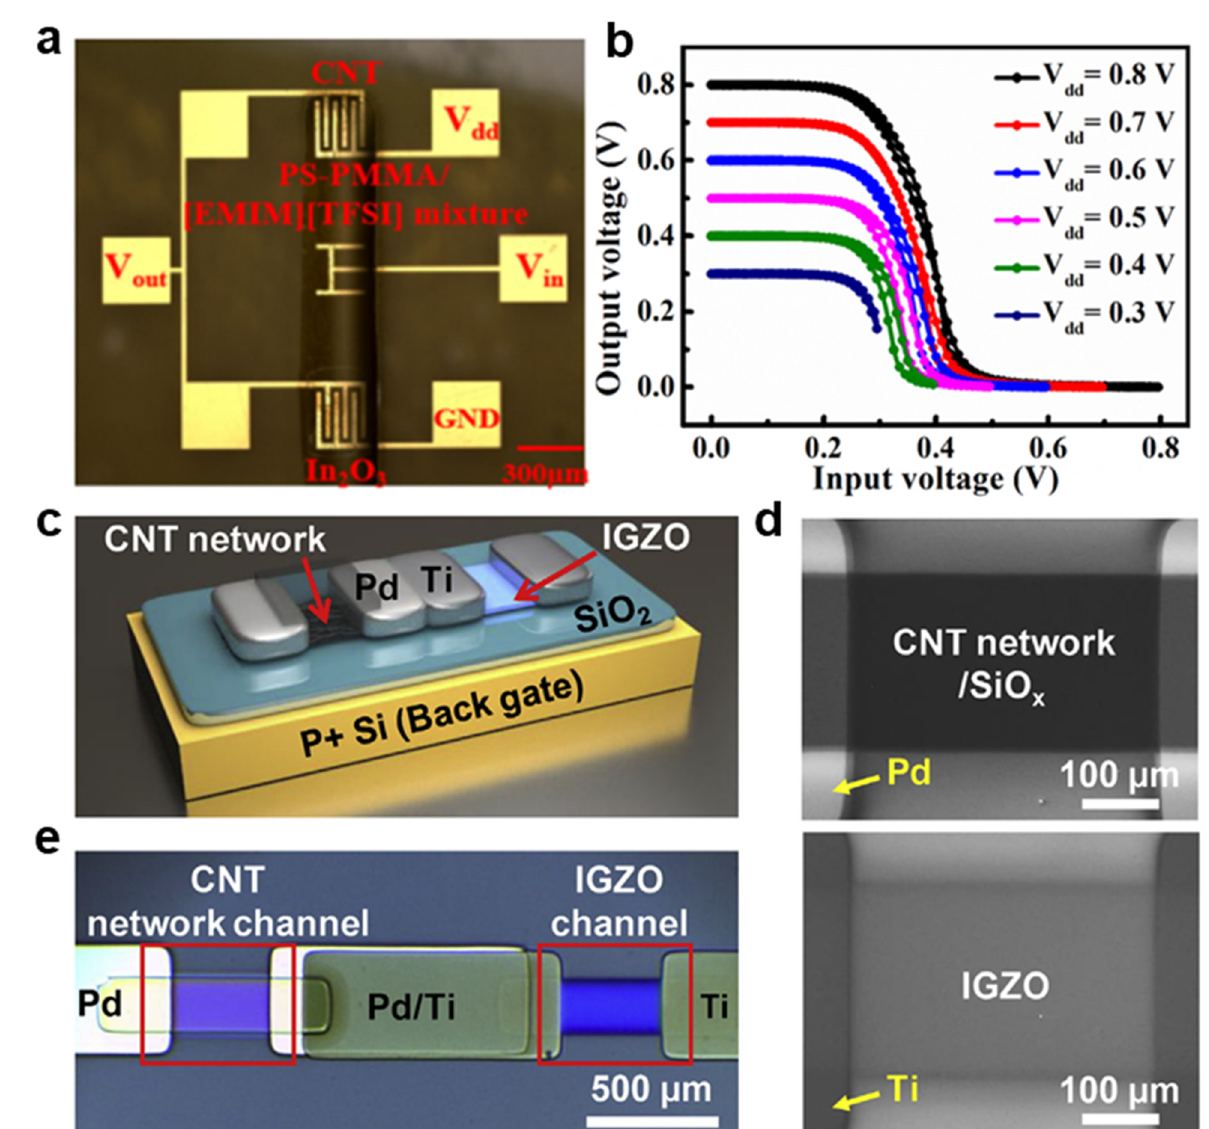
Figure 5. ( a ) Structure of the printed p- CNT and n- In 2 O 3 channel hybrid CMOS inverters. ( b ) Voltage transfer characteristics of the proposed printed hybrid CMOS inverter (adapted from [109] with permission from the American Chemical Society). ( c ) Structure schematic of the hybrid complementary inverter composed with p -type CNT and n -type IGZO TFTs. ( d ) SEM images of the CNT network channel and IGZO channel. ( e ) Optical microscope (OM) image of the hybrid complementary inverter (adapted from [110] with permission from Elsevier B.V.).